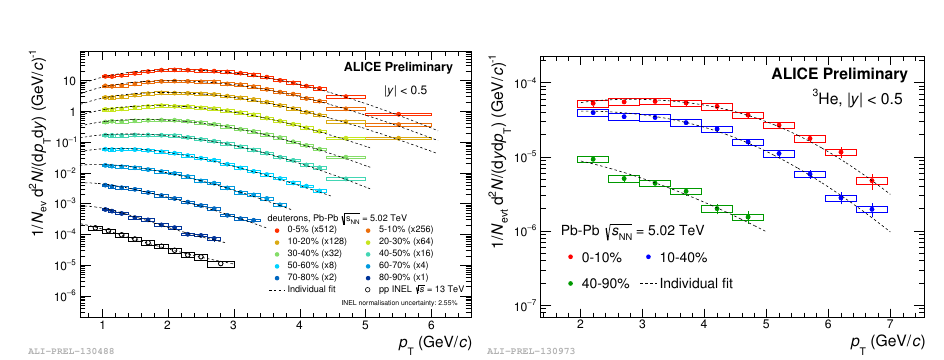
Figure 1. Transverse momentum spectra of deuterons (on the left) and 3 He (on the right) in Pb–Pb collisions at √ s NN = 5 . 02 TeV. The p T production spectrum of deuterons in pp at √ s = 13 TeV is also reported in the left panel. Statistical uncertainties are represented as vertical bars whereas boxes represent the systematic ones. The dashed lines represent the fit to the individual spectra (Blast Wave function in Pb–Pb [8] and the Lévy-Tsallis in pp [9]) to extrapolate the production yield in the unmeasured p T